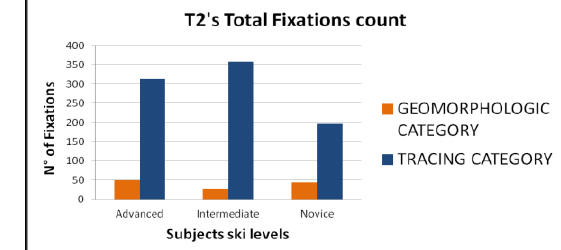
Figure 9 Total fixation count for graphic objects gazed during a creating route task